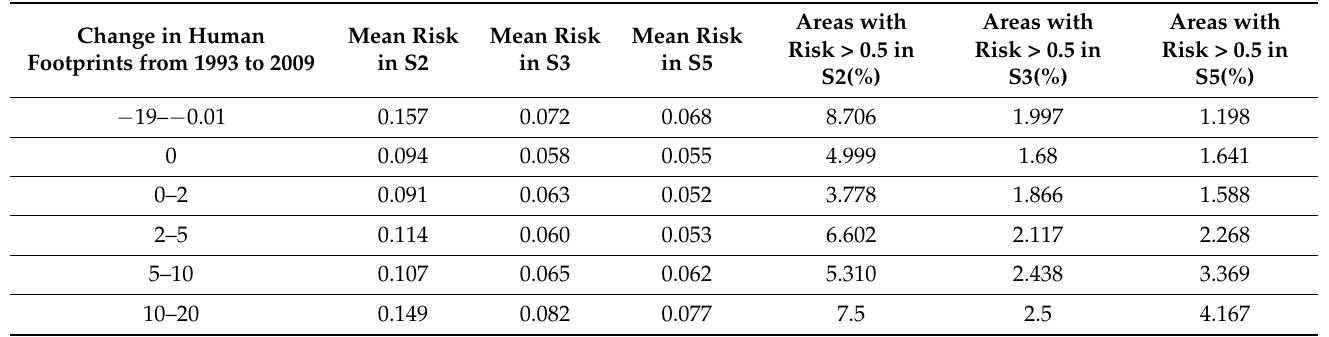
Table 3. Changes of risk areas at different levels of human